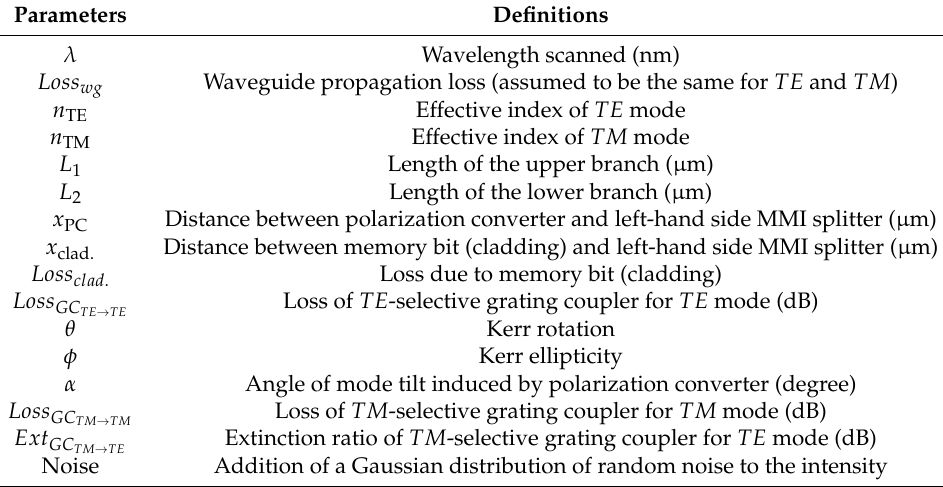
Table 1. Overview of model